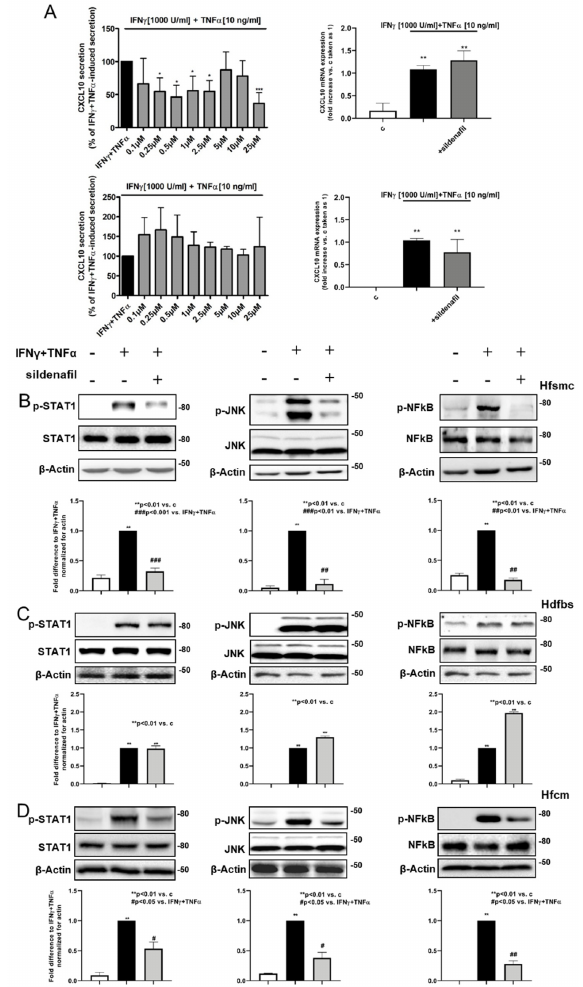
Figure 3. Cytokine-induced CXCL10 release in muscle cells is significantly diminished by sildenafil. Effect of sildenafil STAT 1, JNK and NF-kB phosphorylation in human myocytes (Hfsmc), dermal fibroblasts (Hdfbs) and cardiomyocytes (Hfcm). ( A ) Incubation with increasing doses of sildenafil (1 × 10 − 7 , 2.5 × 10 − 7 , 5 × 10 − 7 , 1 × 10 − 6 , 2.5 × 10 − 6 , 5 × 10 − 6 , 1 × 10 − 5 , 2.5 × 10 − 5 M) for 24 h significantly albeit not strictly dose-dependently reduced CXCL10 protein release by Hfsmc (upper left panel) stimulated with interferon (IFN) γ (1000 U/mL) + tumor necrosis factor (TNF α ) (10 ng/mL) starting from 2.5 × 10 − 7 M of sildenafil dose (54.61 ± 19.05 % of CXCL10 secretion * p < 0.05). Maximal inhibitory effect was at 2.5 × 10 − 5 M of sildenafil concentration (36.55 ± 6.61 % of CXCL10 secretion, ** p < 0.01). Data are obtained from three different experiments using different cell preparations. 24 h treatment with IFN γ (1000 U/mL) + TNF α (10 ng/mL) significantly upregulated CXCL10 mRNA expression in Hfsmc and Hdfbs; sildenafil (1 µ M) did not exert any significantly change on CXCL10-cytokines induced gene level in both cell types (upper and lower right panels). CXCL10 mRNA expression is determined by RT-qPCR and is expressed as fold increase vs. IFN γ +TNF α -induced expression taken as